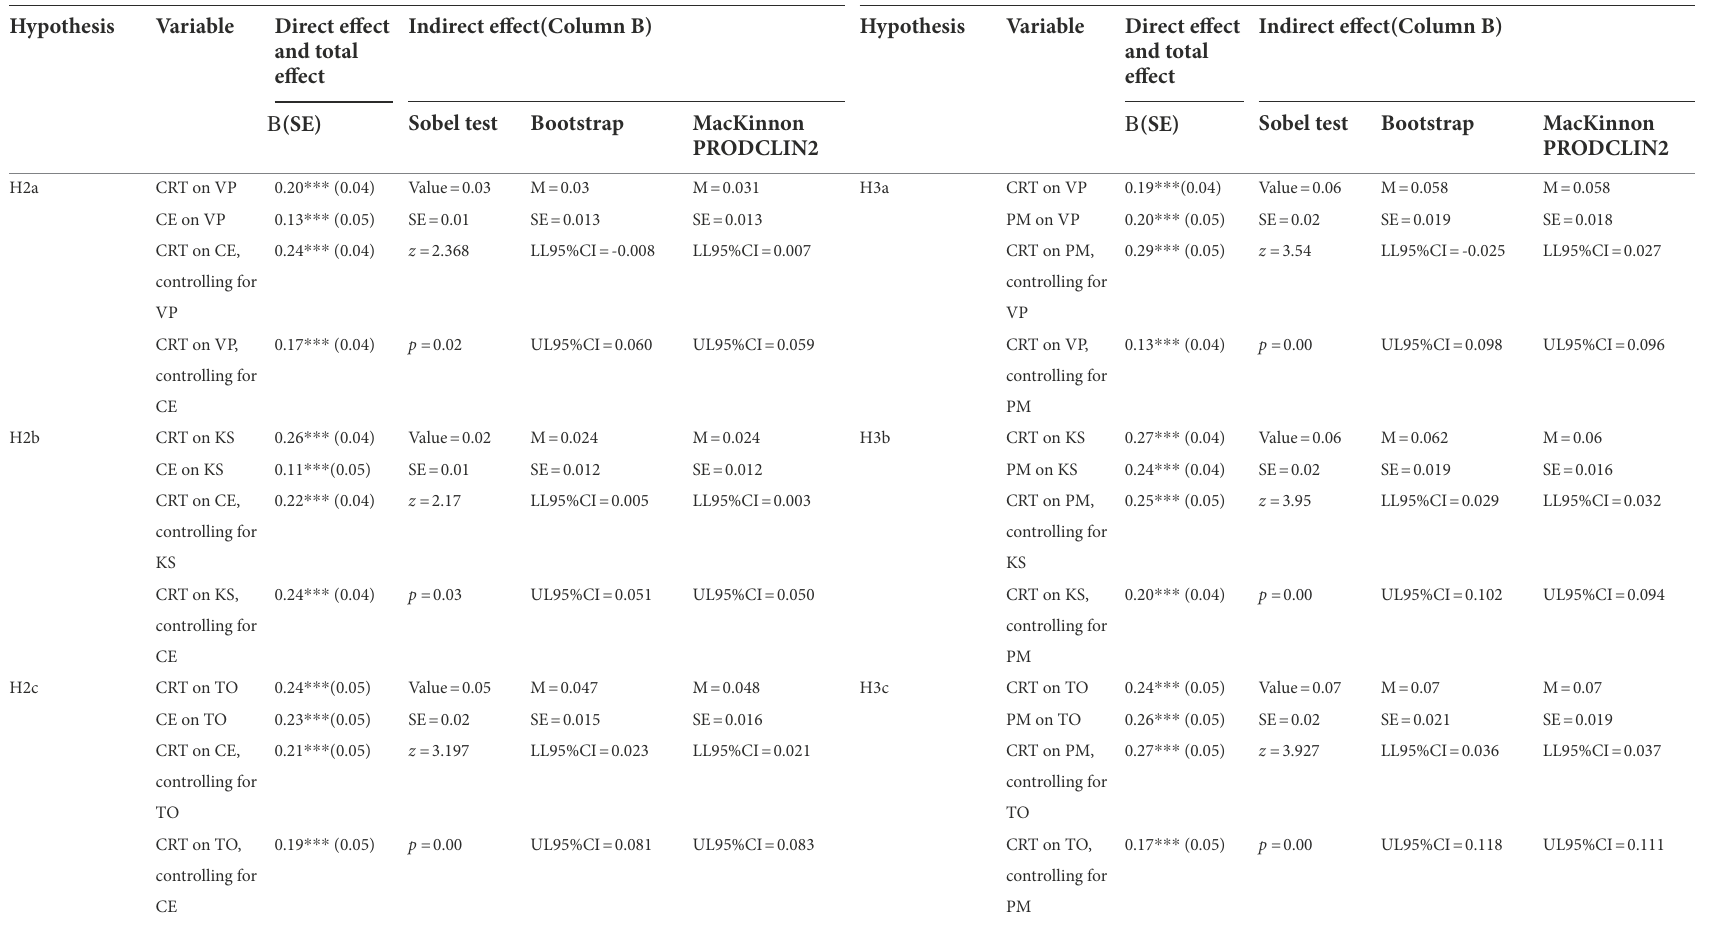
TABLE 5 The mediating effect of creative self-efficacy and positive